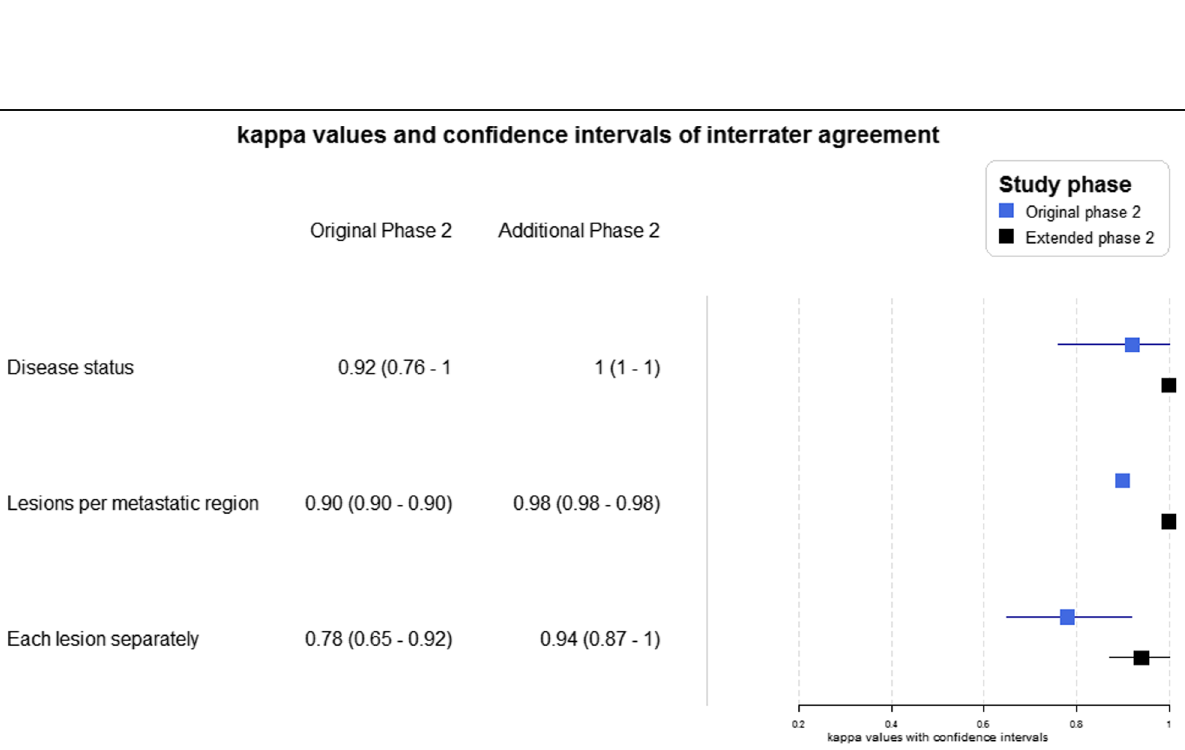
Fig. 5 Overview of patient images who were administered 4 MBq/kg who presented with common lesion locations: local recurrence (first row), lymph node metastases (middle row) and bone metastases (last row), each presented as a MIP image (at T60, 3 min/bp) followed by axial images (axis line displayed on MIP image) of all reconstructed time frames (T60, 1.5 and 3 min/bp and T180, 1.5 and 3 min/bp), and the high dose CT image